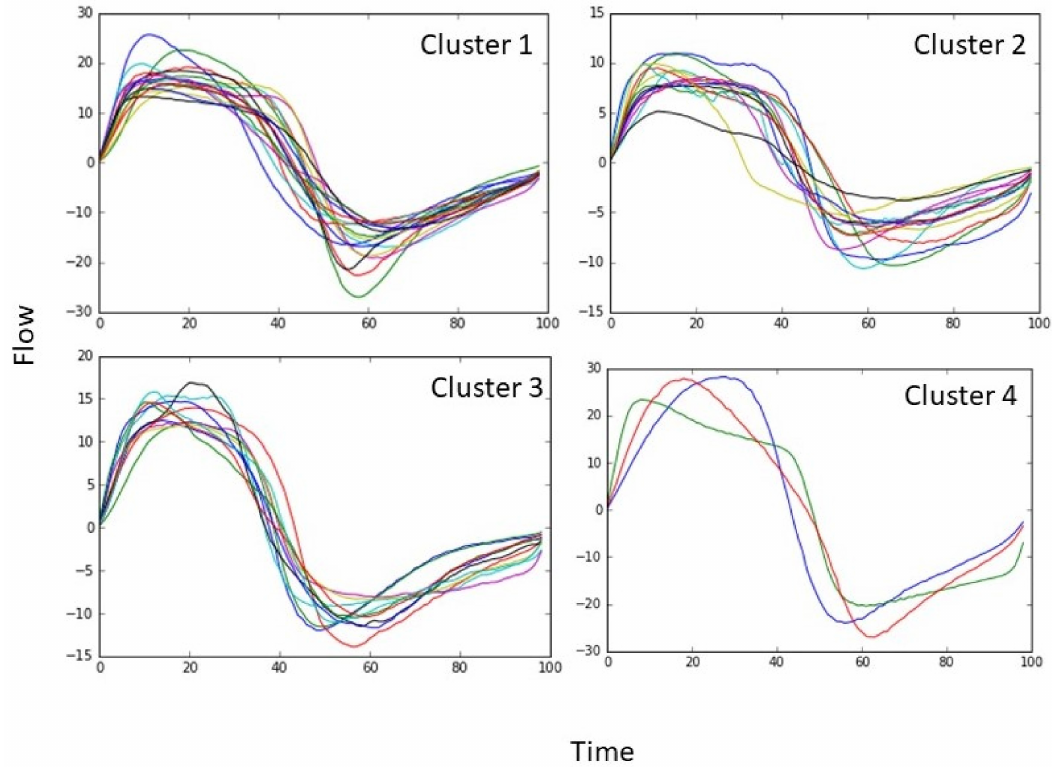
Figure 2. Mean breaths for each participant. Normalised for time ( X -axis) and flow ( Y -axis), the four clusters.